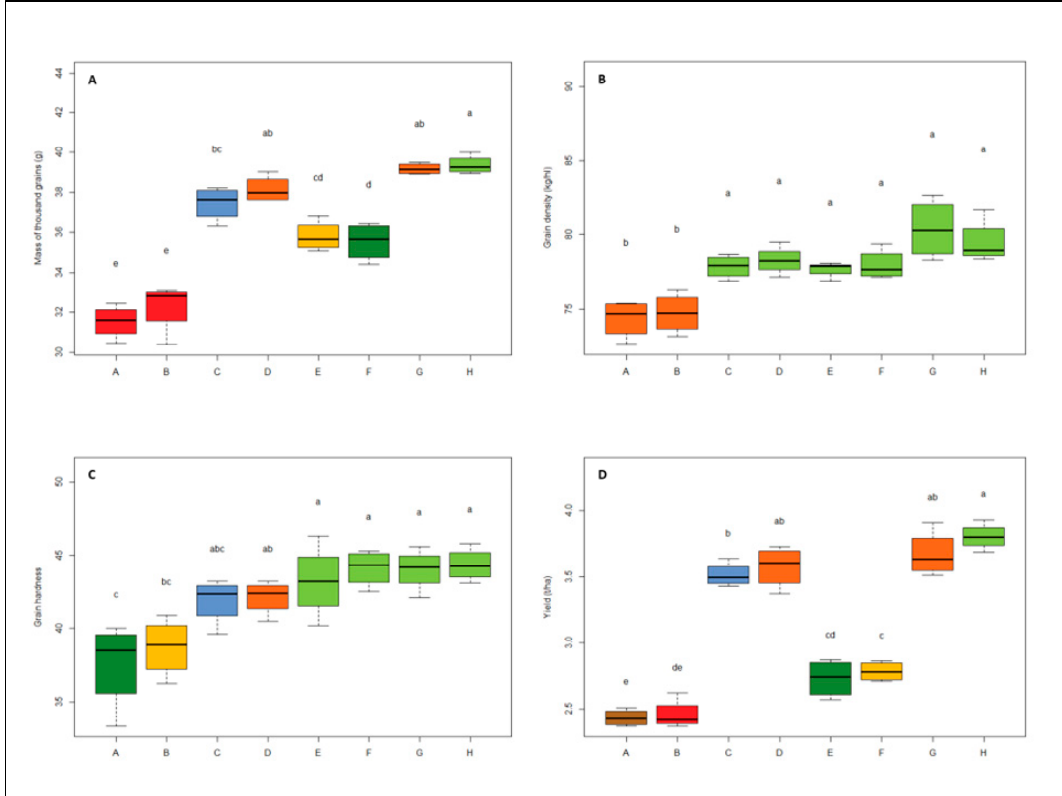
Figure 6. ( A ) Mass of thousand grains (MTG); ( B ) grain density (GD); ( C ) grain hardness (GH); ( D ) yield (Y) of wheat: concentrations (ASA3, ASA5) *terms of applications (T1/T2, T3/T4) *years (2013, 2014). Boxes: the interquartile range. Lines across the boxes: the average of the values. The line above and below the vertical dashed lines: the maximum and minimum values. Boxes of the same color indicate a group of similar objects. The letters a, ab, b, ... indicate similar objects in order of highest average value. A = ASA3 *T1/T2 *2013; B = ASA5 *T1/T2 *2013; C = ASA3 *T1/T2 *2014; D = ASA5 *T1/T2 *2014; E = ASA3 *T3/T4 *2013; F = ASA5 *T3/T4 *2013; G = ASA3 *T3/T4 *2014; H = ASA5 *T3/T4 *2014.